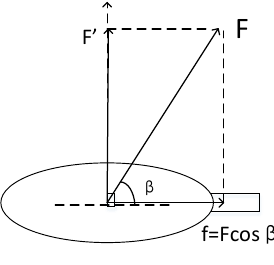
Figure 12. Creation of